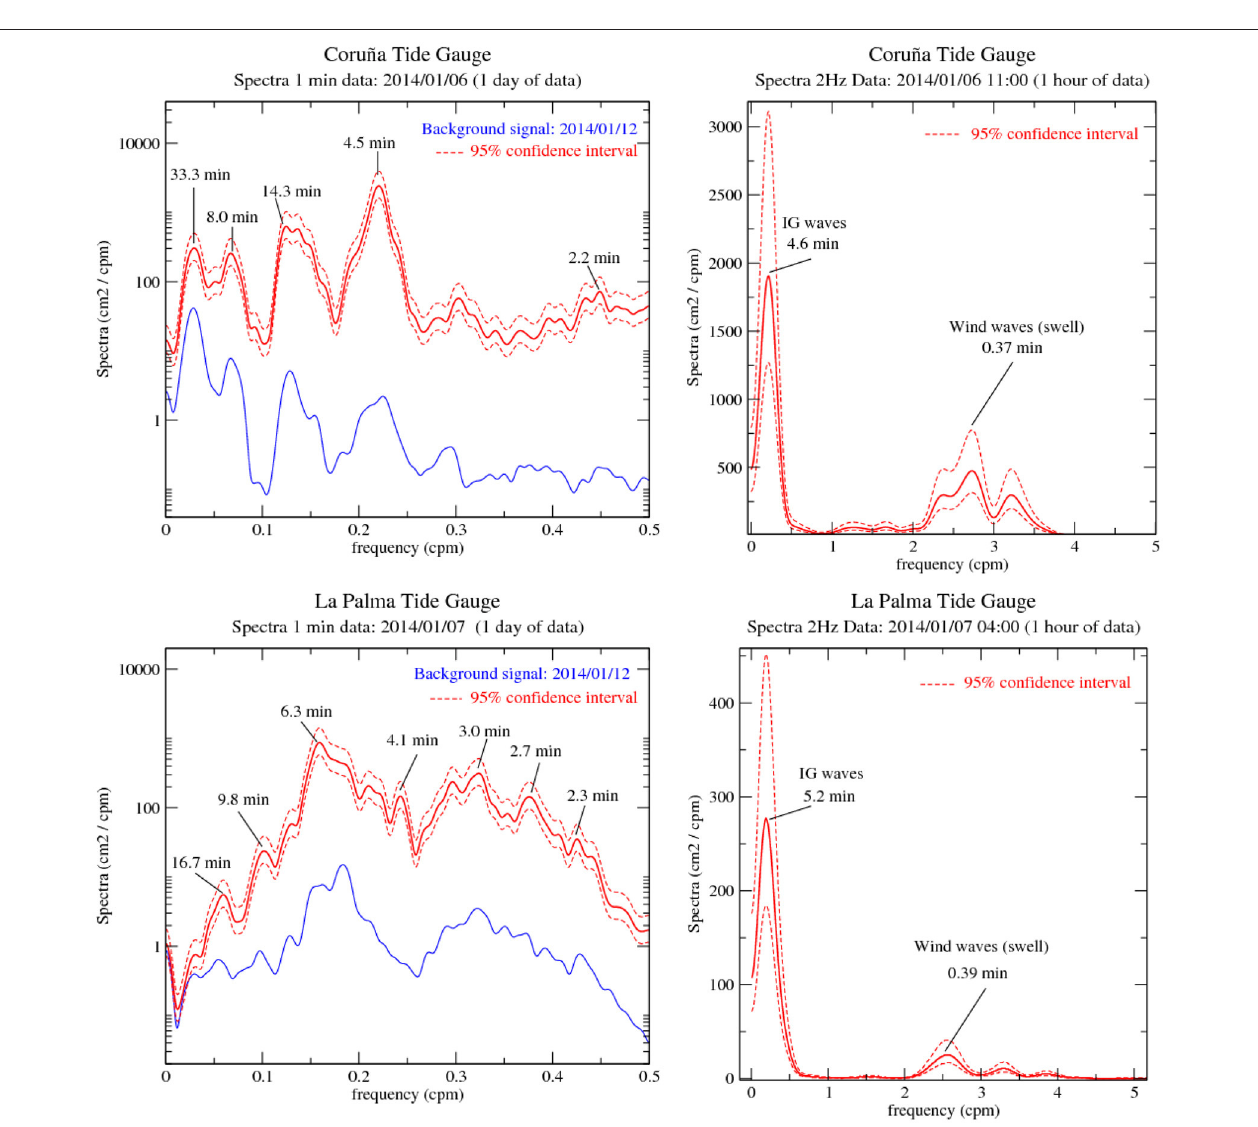
FIGURE 9 | Spectral analysis for Coruña and La Palma tide gauges, during the storm of January 6–7, 2014. Left: spectra applied to 1 day of 1-min data, right: spectra applied to 1hour of 2Hz data. The 1- min and 2Hz data have been high-pass filtered (periods < 3h and periods < 45min respectively). Red lines: spectra for 1 day/hour of maximum sea level oscillations (and 95% confidence intervals). Spectra from the background signal was added to the 1-min spectra (blue line) and a logarithmic vertical scale used in this case for easier comparison of the peaks. Spectra method: auto-covariance function smoothed with a Parzen lag window (40 degrees of freedom). Swell waves and infragravity waves are observed in the 2Hz